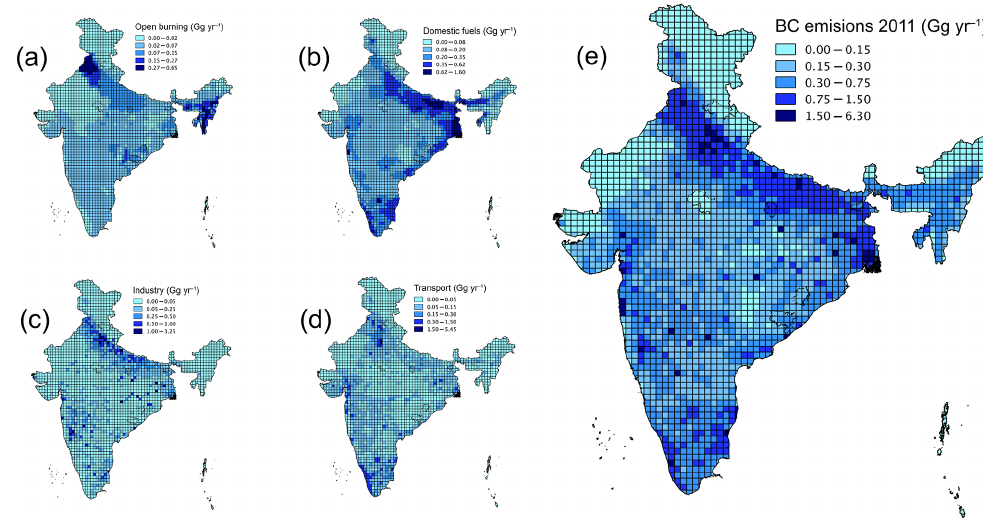
Figure 8. (a–d) Maps of major sector emissions and (e) spatial variability of national emissions total for BC.